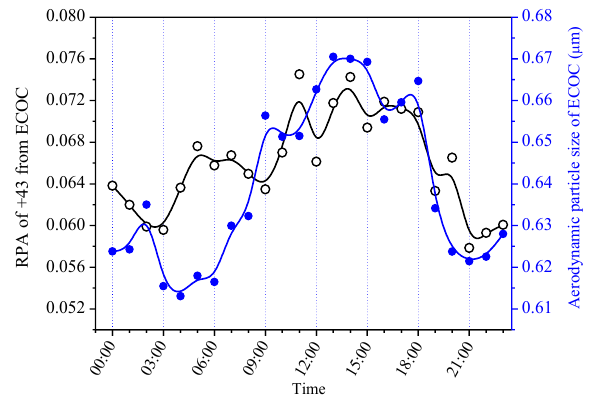
Figure 9. Diurnal variations in relative peak area (RPA) of m/z + 43 from ECOC particles and the average aerodynamic particle size of ECOC